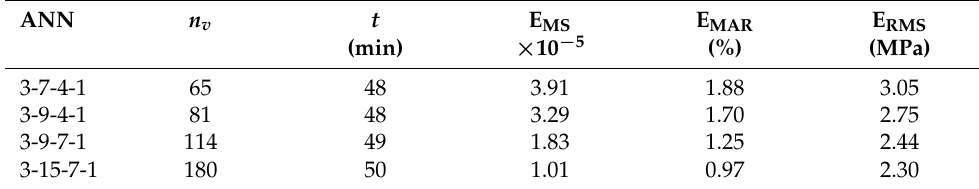
Table 1. Results concerning the training of the four ANN flow